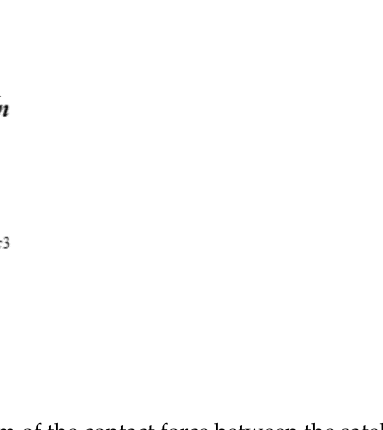
Figure 9. Schematic diagram of the contact force between the satellite and the